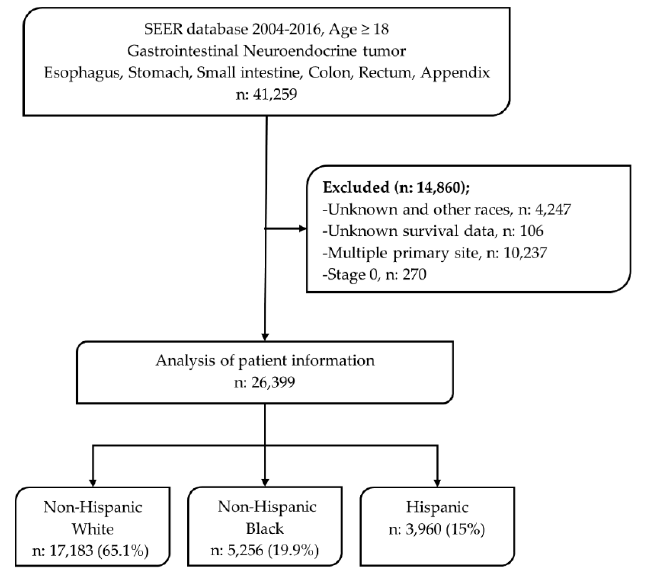
Figure 5. Flow chart to show the selection of patients.